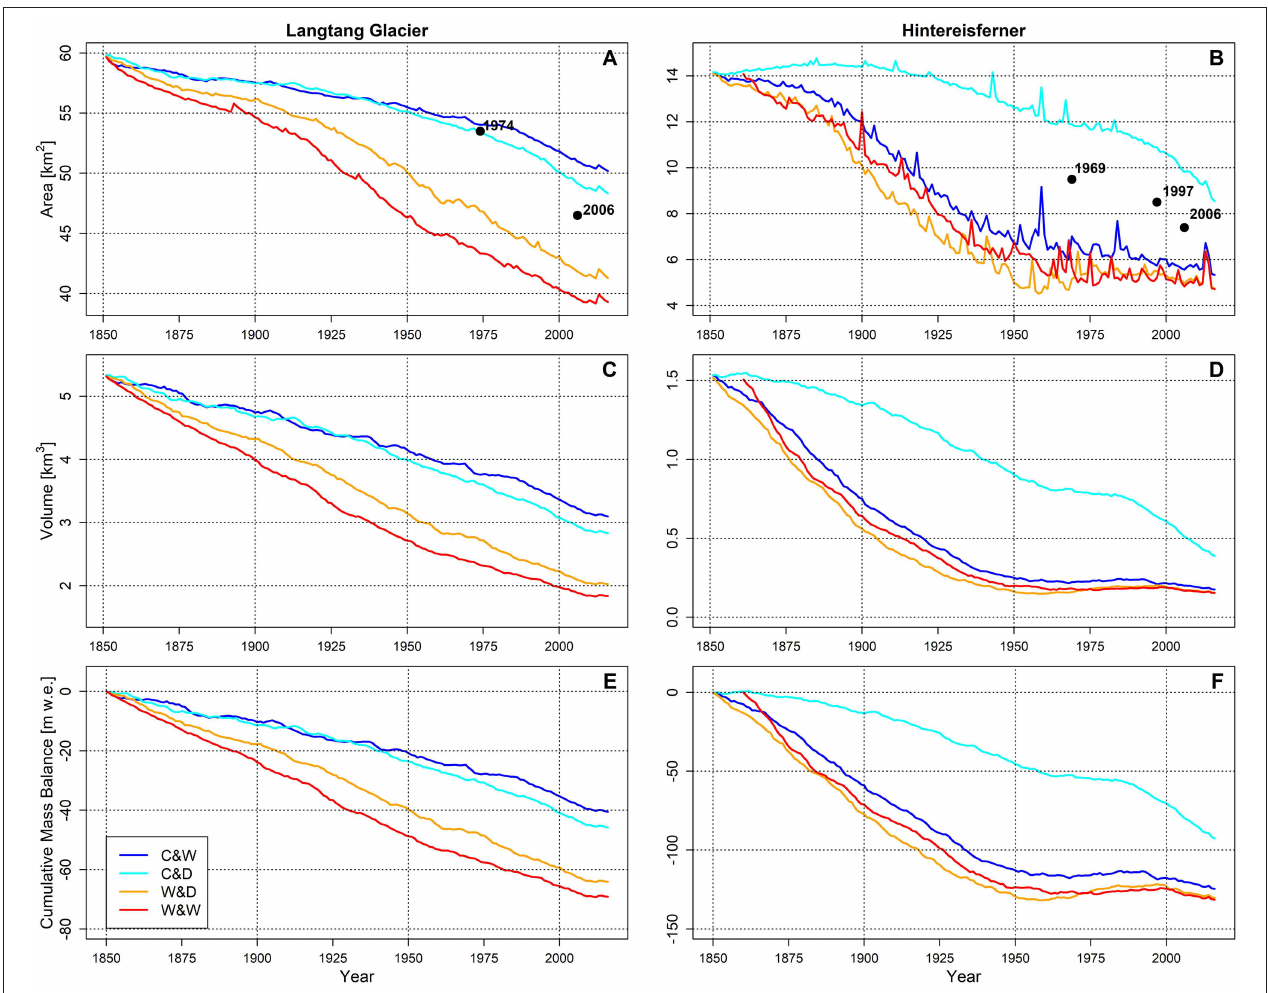
FIGURE 4 | Modeled changes in glacier area (A,B) , volume (C,D) , and specific mass balance (E,F) of the Langtang Glacier (A,C,E) and Hintereisferner (B,D,F) for four different historical climate change simulations (CW: cold and wet; CD: cold and dry; WW: warm and wet; WD: warm and dry). The black points denote the observed glacier extents at Langtang Glacier (1974, 2016; Pellicciotti et al., 2015; Ragettli et al., 2016) and Hintereisferner (1969, 1997, 2006; Abermann et al., 2009; Patzelt, 2013; Charalampidis et al.,